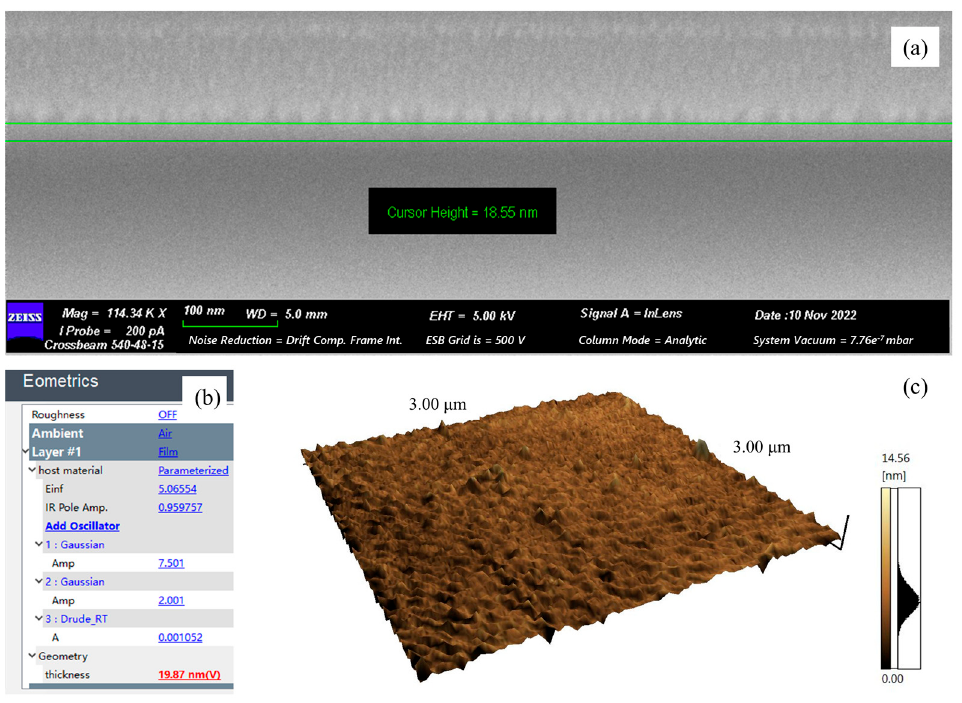
Figure 1. ( a ) The cross-section SEM image, ( b ) the screen shot of Eometrics , an ellipsometer control software (version 3.5.5.0407), and ( c ) the AFM image of the Cr film sputtered at 100 s.